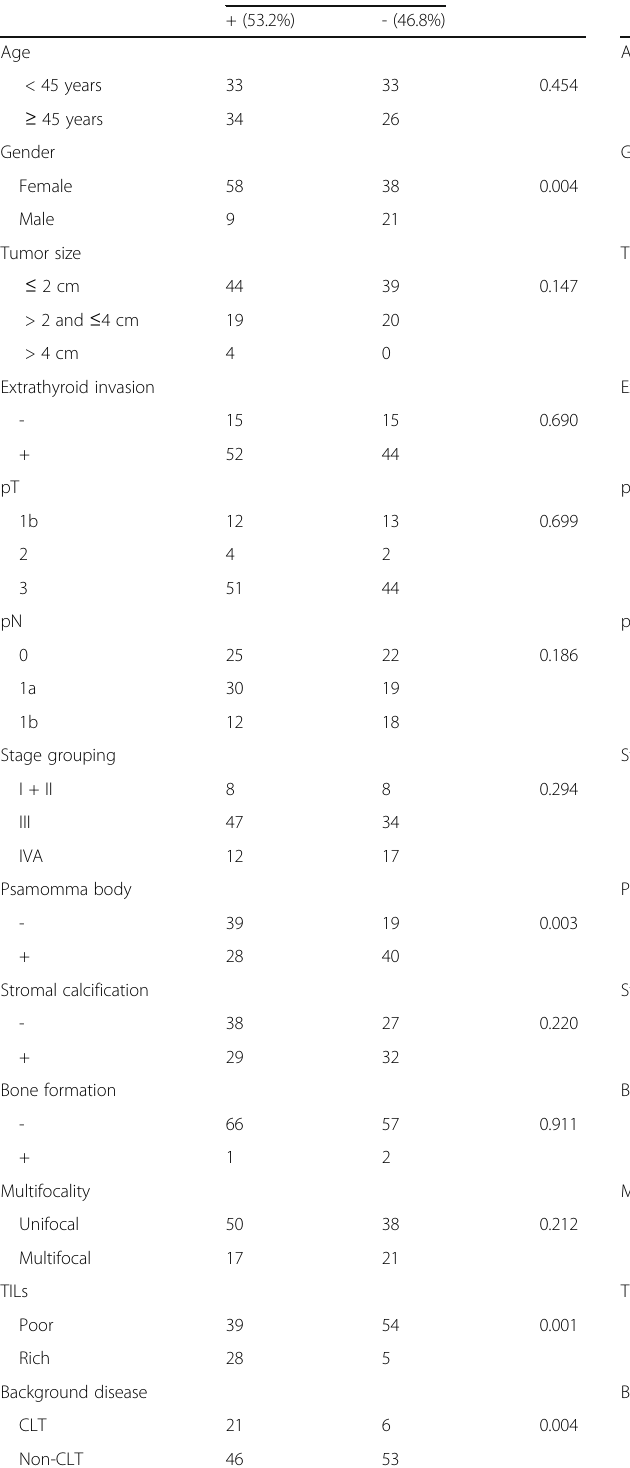
Table 1 The correlation between the PD-L1 expression and other Table 2 The correlation between the PD-1 expression and